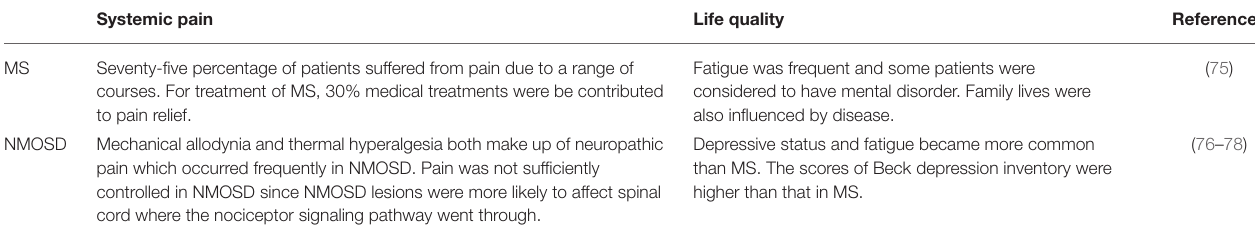
TABLE 3 | Systemic pain symptoms in MS and NMOSD.